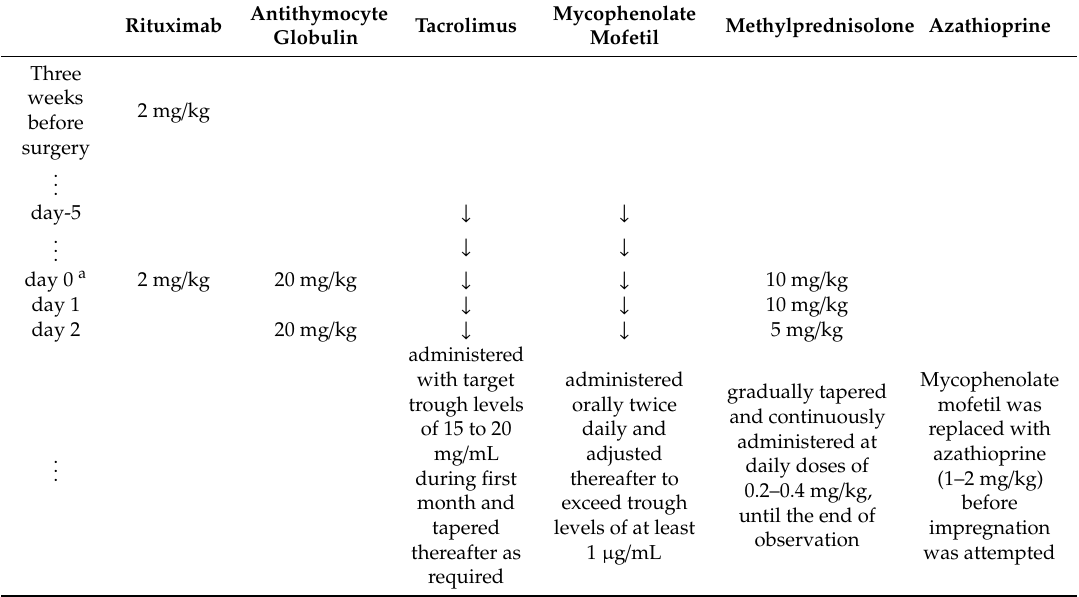
Table 3. Immunosuppressive protocol used in this